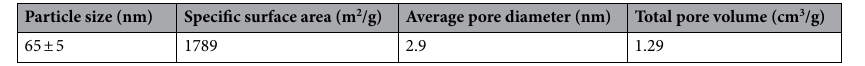
Table 2. BET data for ZIF-8 MOFs prepared by solvothermal method.